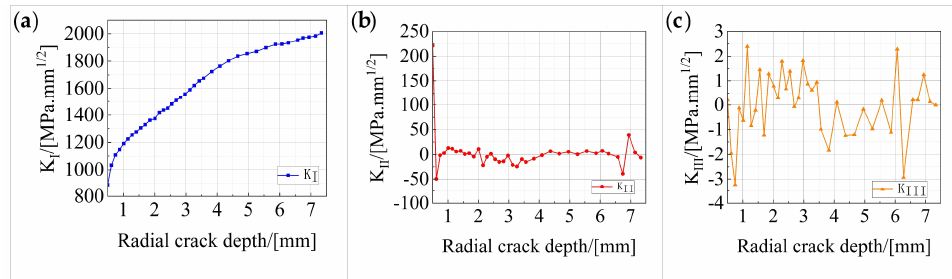
Figure 20. Variation in the stress intensity factors with the crack depth: ( a ) variation in K I with the crack depth; ( b ) variation in K II with the crack depth; ( c ) variation in K III with the crack depth.